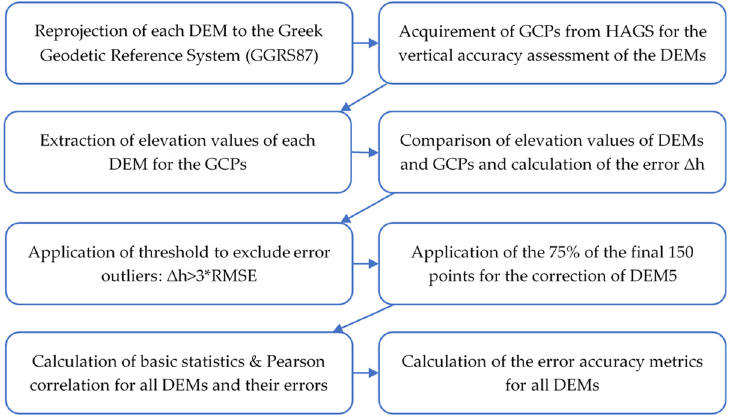
Figure 5. Methodology of DEM quality assessment.